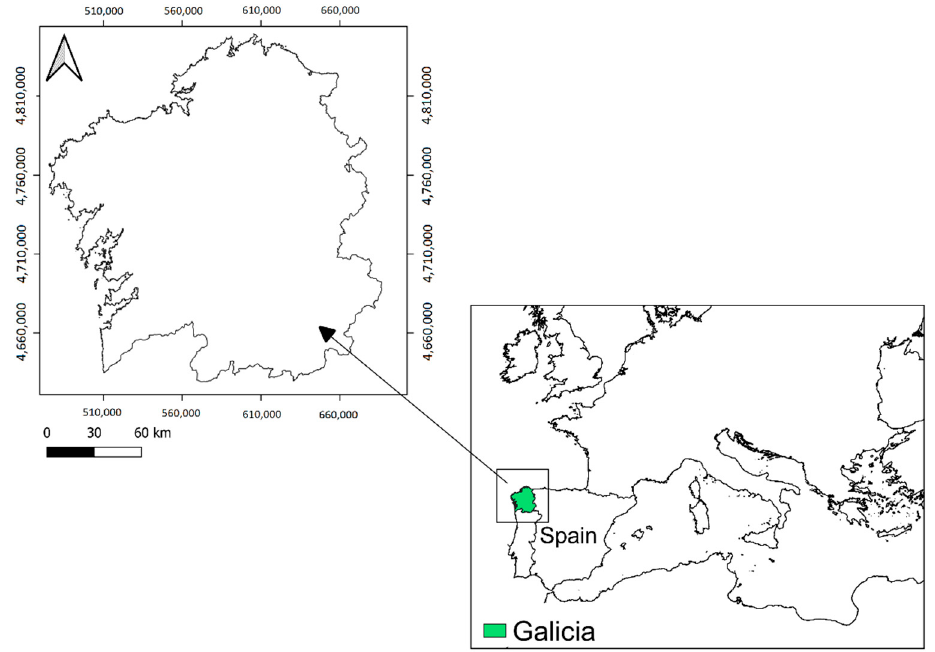
Figure 1. Study area: Galicia (Northwest of Spain).